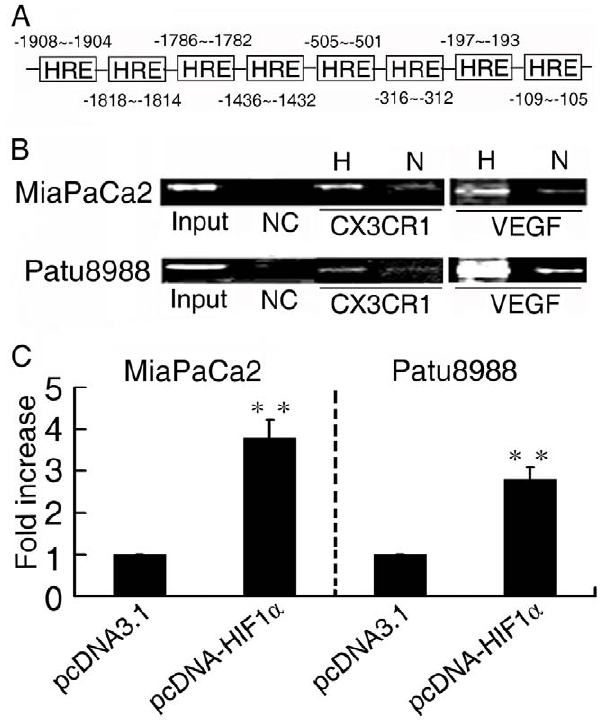
Figure 3. HIF-1 a upregulated CX3CR1 promoter activity. ( A ) The DNA sequence of the CX3CR1 promoter. HRE sites are located at the different site. ( B ) Chromatin immunoprecipitation analysis on MiaPaCa2 (upper) and Patu8988 (lower) cells. The PCR products of VEGF promoter were used as positive control. H, N and NC indicates hypoxia, normoxia and negative control, respectively. ( C ) Luciferase analysis in MiaPaCa2 (left) and Patu8988 (right) cells. Cells were cotransfected with pGL3- CX3CR1 (1 m g) and pcDNA3.1-HIF1 a plasmids (1 m g). Relative luciferase analysis was measured by Dual-Luciferase Reporter Assay System. Y axis: pGL3-CX3CR1 relative luciferase activity. ** P , 0.01 versus control.